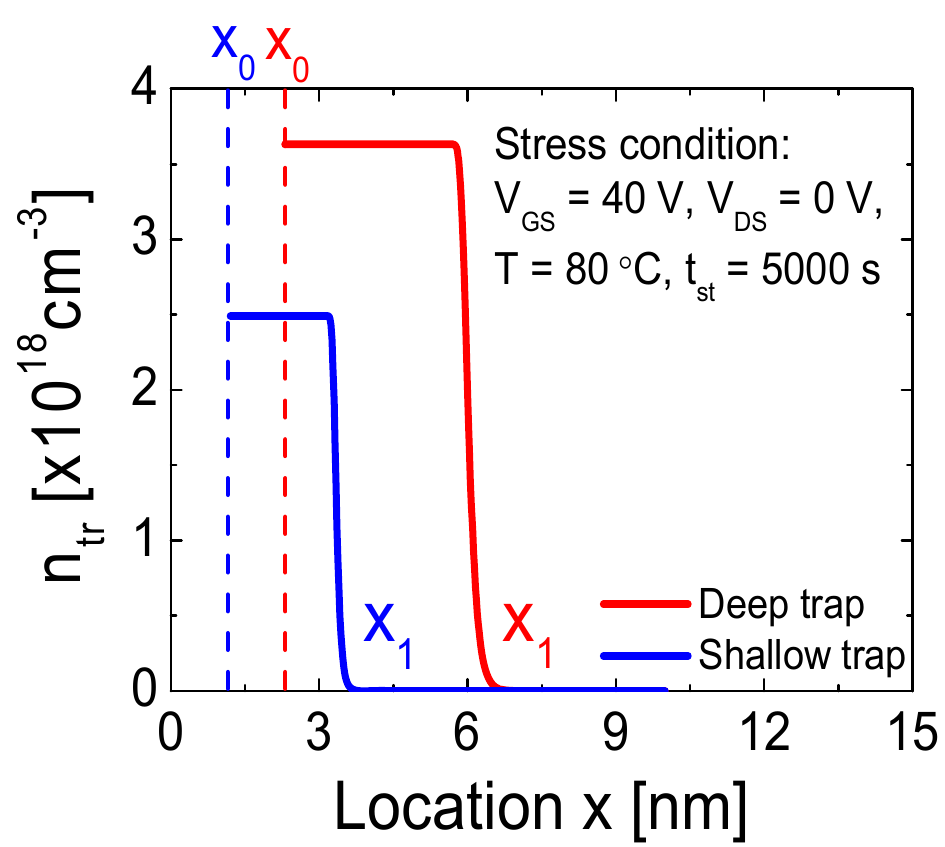
Figure 9. Extracted trapped electron distribution in the shallow and deep gate dielectric traps after the application of the PBTS ( V GS = 40 V, V DS = 0 V, 80 ◦ C) for 5000 s in the fabricated SA-TG coplanar IGZO TFT.